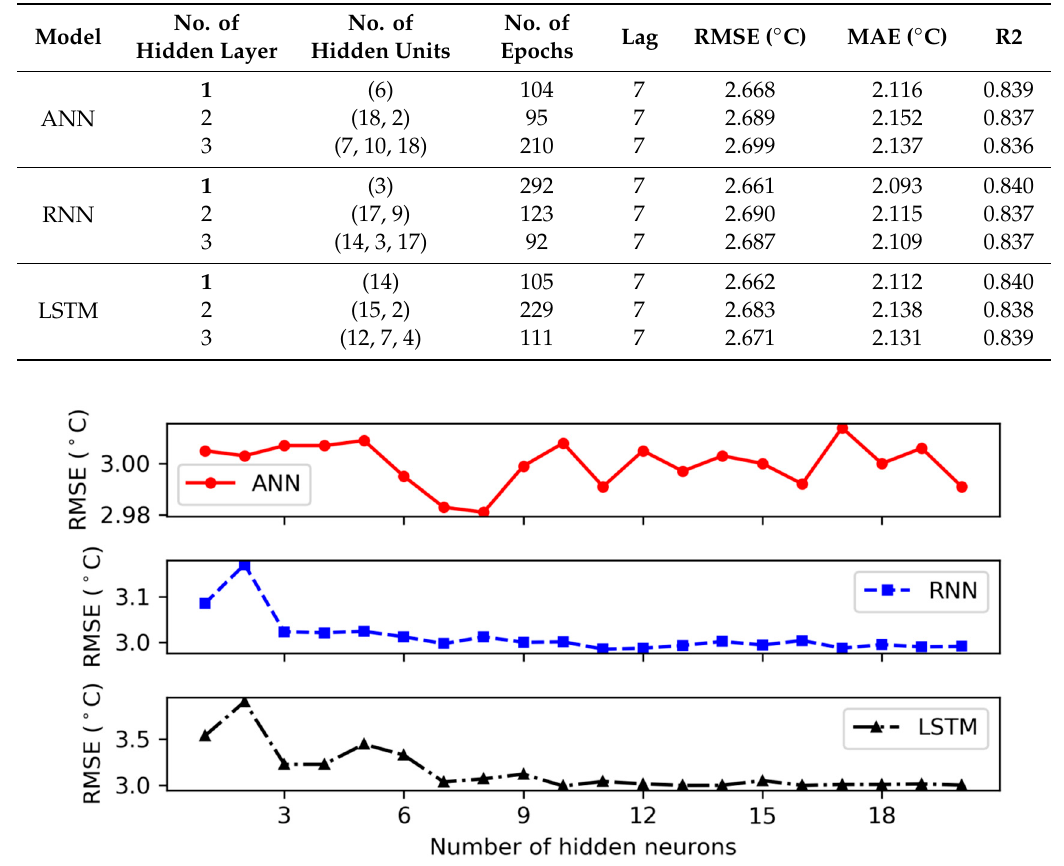
Figure 5. Root mean square error corresponding to different number of hidden neurons for 1 hidden layer in winter.